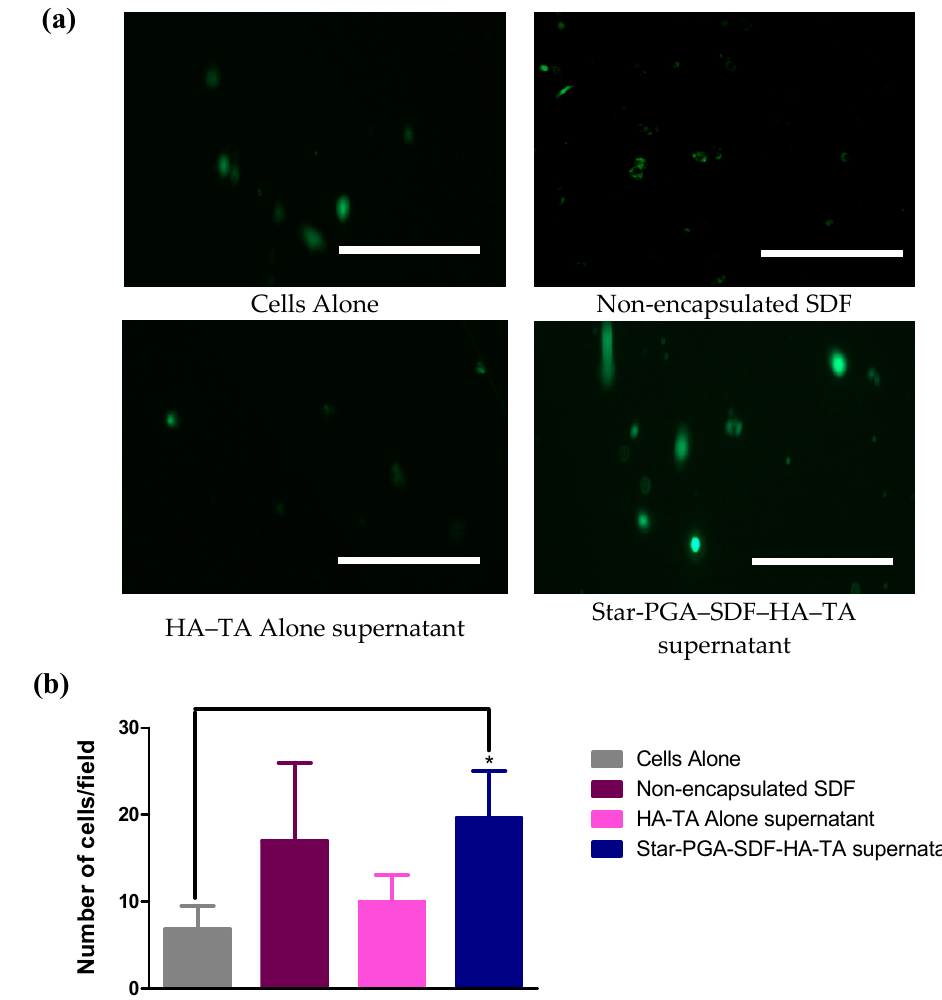
Figure 10. Migration of Human Umbilical Vein Endothelial Cells (HUVECs) through a Transwell ® membrane caused by fresh, non-encapsulated Stromal-Derived Factor 1 α (SDF), HA–TA alone supernatant or star-poly(glutamic acid) (PGA)–SDF(50:1)-HA–TA supernatant and compared to untreated cells (cells alone) ( a ) Calcein-stained HUVECs imaged after migration through the Transwell ® membrane at 24 h Scale bar = 100 µm ( b ) Average number of HUVECs migrated per field—significantly more cells had migrated in the presence of the star-PGA–SDF–HA–TA supernatant than in the untreated cells (cells alone) group. SDF concentration 4.1 ng/mL. ( n = 3). * p < 0.05.